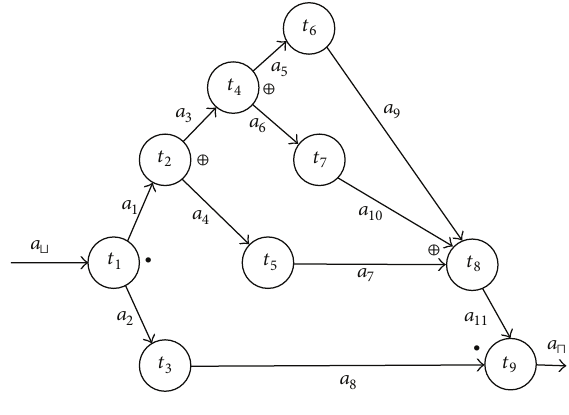
Figure 1: Example of a workflow.